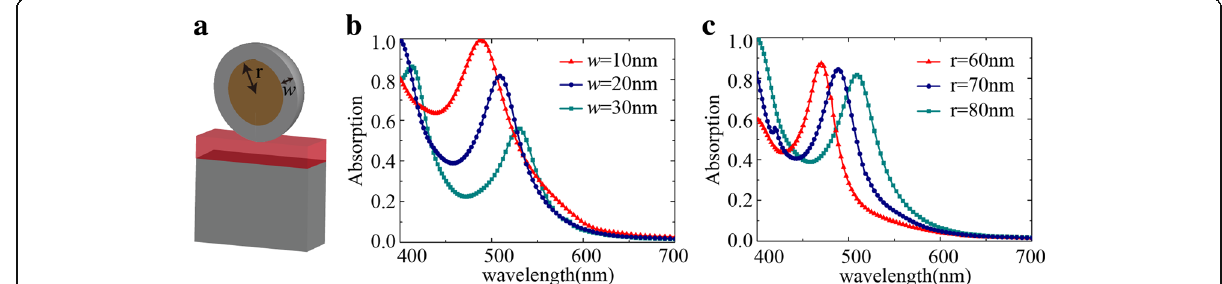
Fig. 7 Simulation of the Ag-Cu NPs structure with Cu-Ag alloy on the surface. a Schematic of the model. b Absorption spectra with change of thickness w . c Absorption with changes of radius